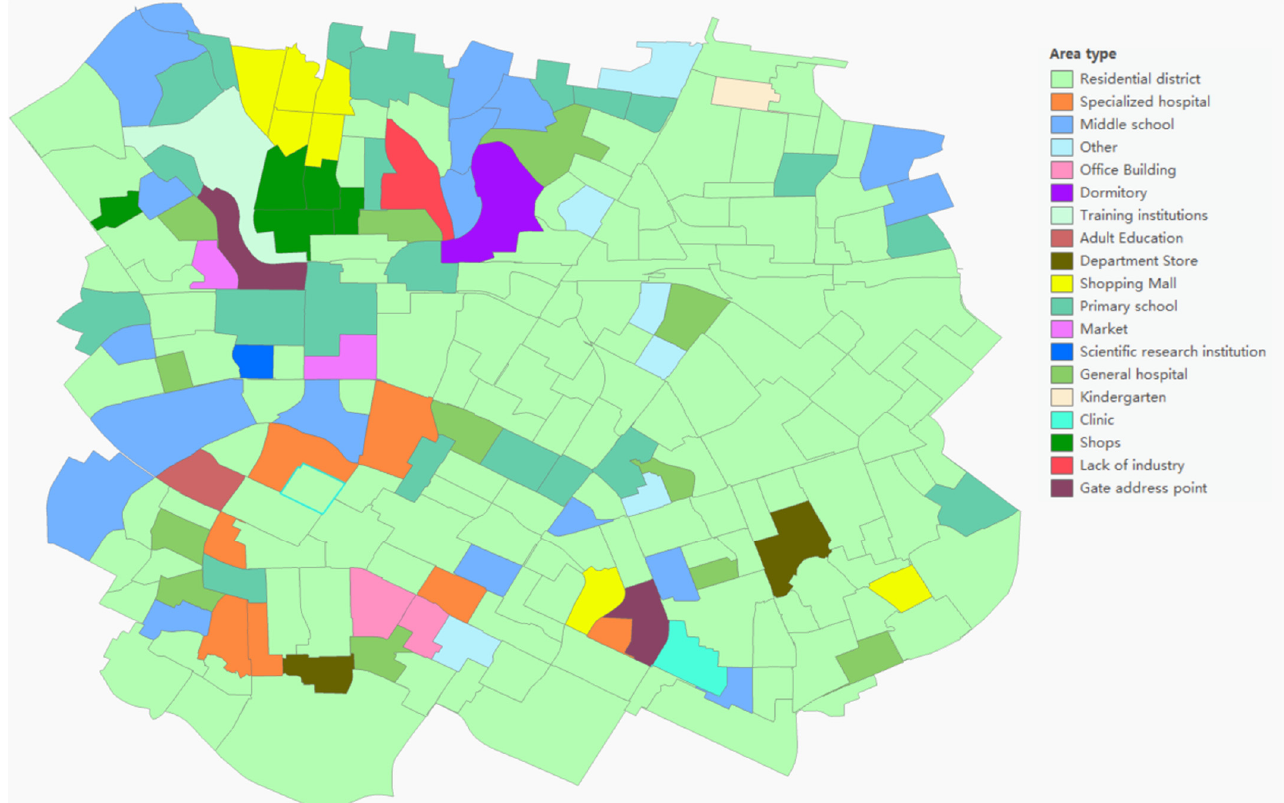
Figure 1. Division of urban functional areas (dividing the city into 19 regional types).